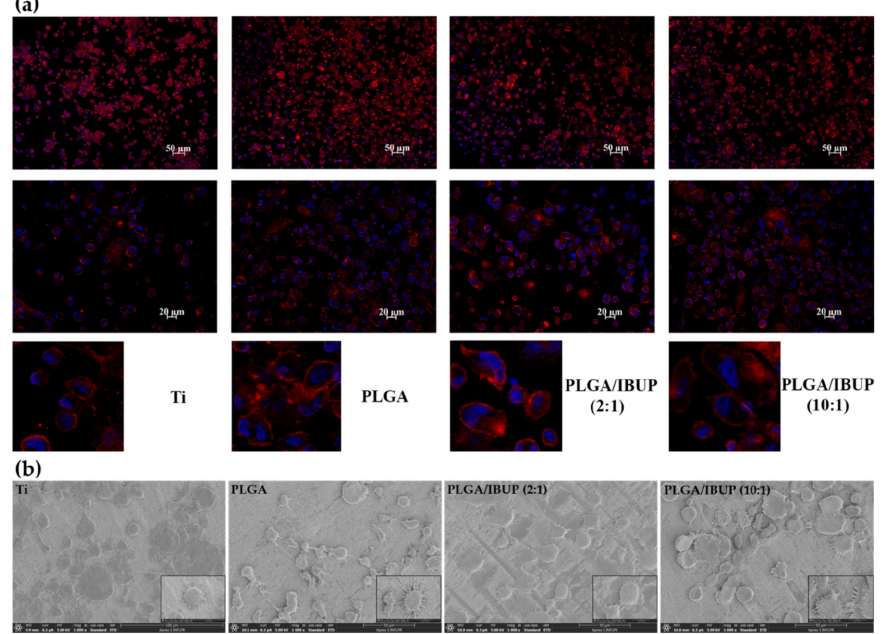
Figure 8. Morphological features of human macrophages on PLGA-based coatings after 3 days, evidenced by: ( a ) fluorescence microscopy showing actin filaments (red) and nuclei (blue), scale bar 50 and 20 µ m; ( b ) SEM investigation, scale bar 50 µ